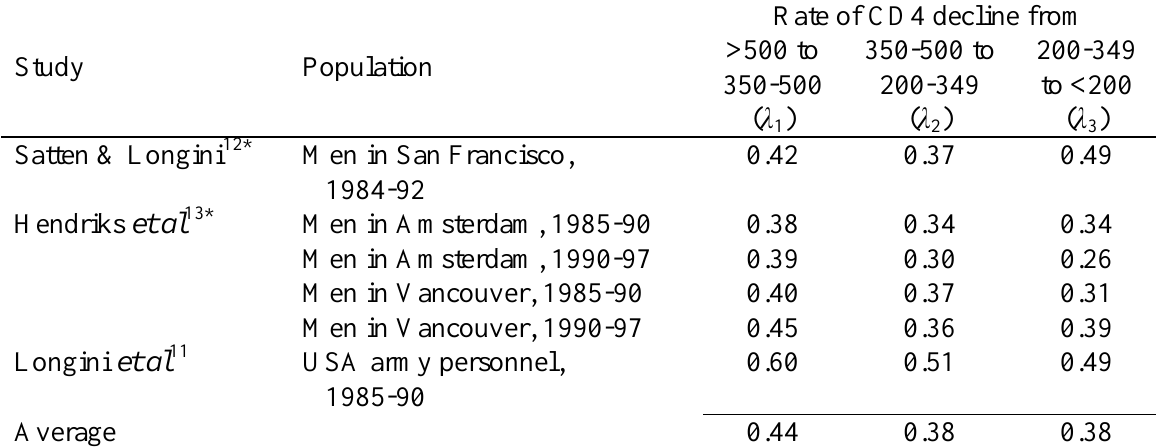
Table 1: Estimated annual rates of CD4 decline in the absence of ART